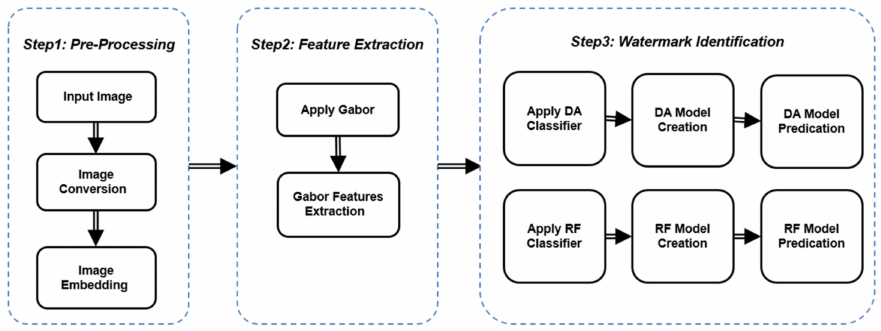
Figure 7. Proposed method